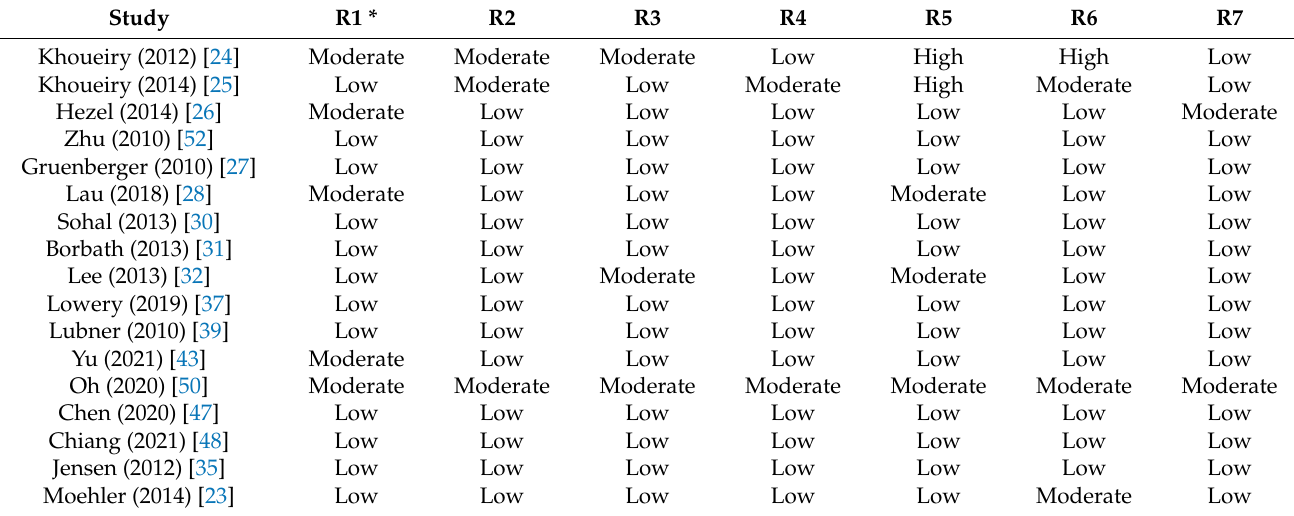
Table 6. ROBINS-1 of non-RCT (risk of